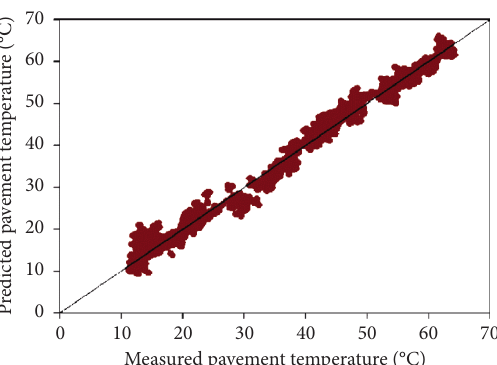
Figure 8: Measured versus predicted maximum temperature at 2cm depth [equation (4)] during